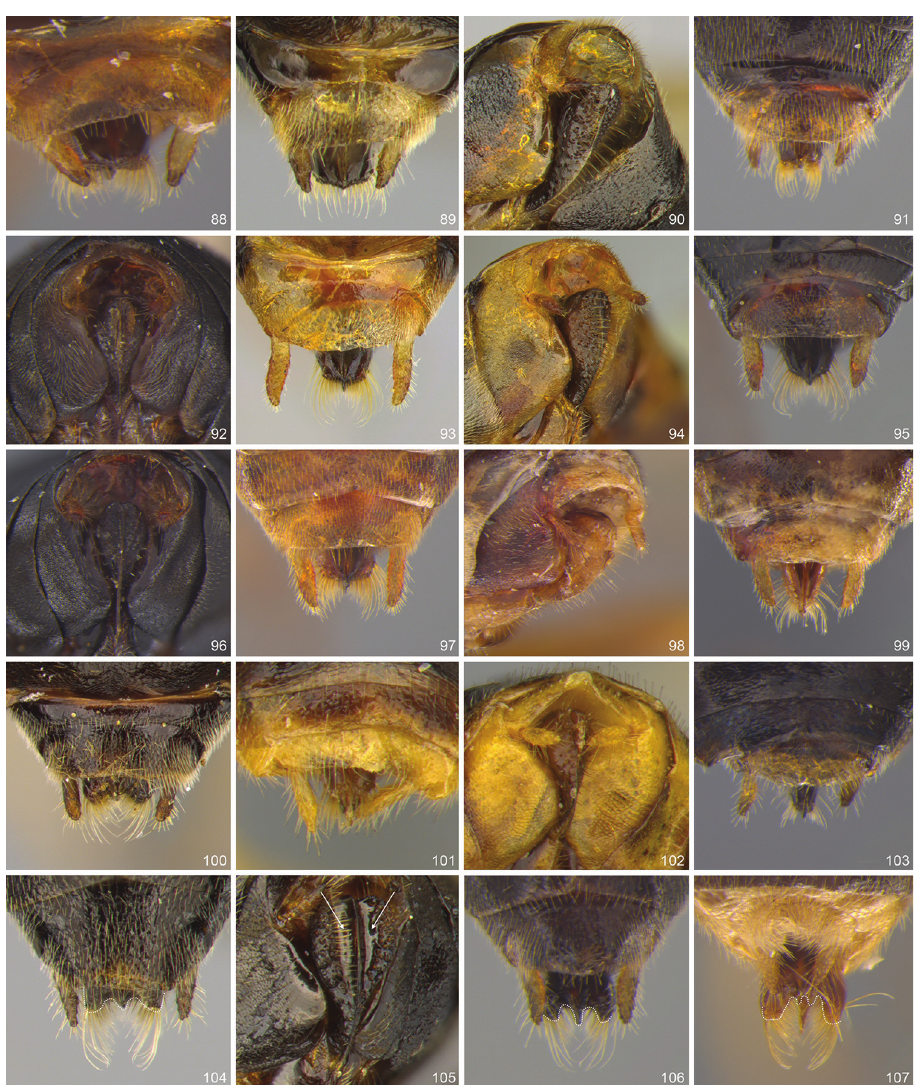
Figures 88–107. Valvula 3 of Pristiphora . 88 alpestris DEI-GISHym20881 89–90 pseudocoactula DEI-GISHym19952 91–92 micronematica group (DEI-GISHym20879) 93–94 carinata group (DEI- GISHym19835) 95–96 lativentris DEI-GISHym19838 97 carinata group (DEI-GISHym19966) 98–99 carinata DEI-GISHym20847 100 pseudogeniculata DEI-GISHym20832 101–102 exigua DEI- GISHym31527 103 retusa DEI-GISHym20965 104 cincta DEI-GISHym31723 105 appendiculata DEI-GISHym80025 (arrows indicate distinct scopa) 106 pallidiventris DEI-GISHym20964 107 punc- tifrons